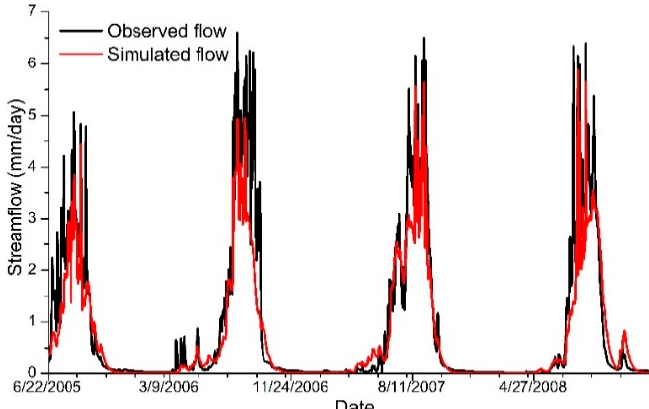
Figure 5. Comparison of simulated and observed streamflow for the validation period (2005–2008).